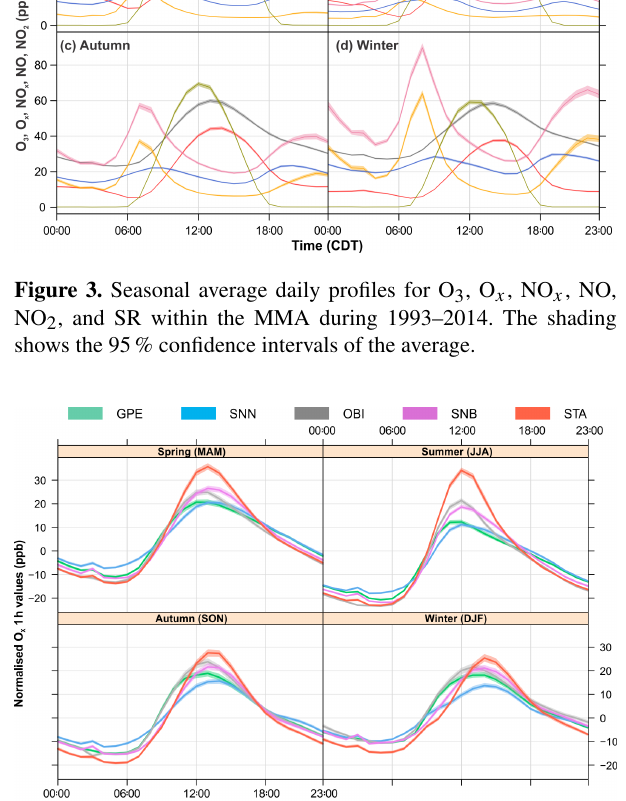
Figure 5. (a) Annual cycles of O 3 , temperature, rainfall, RH, and SR constructed by averaging records from 1993 to 2014 for a 1- year period. (b) . Trends in AV s of O 3 recorded at the five monitor- ing sites within the MMA from 1993 to 2014. The decline in AV s observed is due to the economic crisis experienced in Mexico dur- ing 1994–1996, followed by persistent increases in AV s since 1998. (c) Annual rates of change in O 3 AV s by site before and after